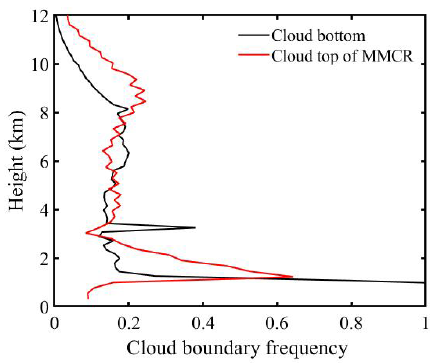
Figure 18. Frequency distribution of cloud boundaries at vertical heights at Xi’an Jinghe National Meteorological Station from